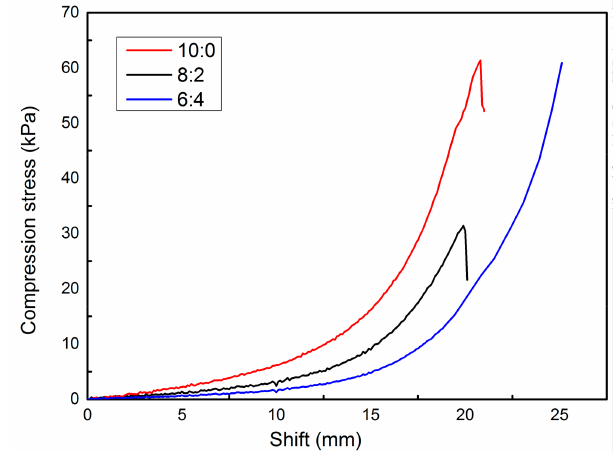
Figure 4. Compressive stress-strain curves for S-CH and P-CH.